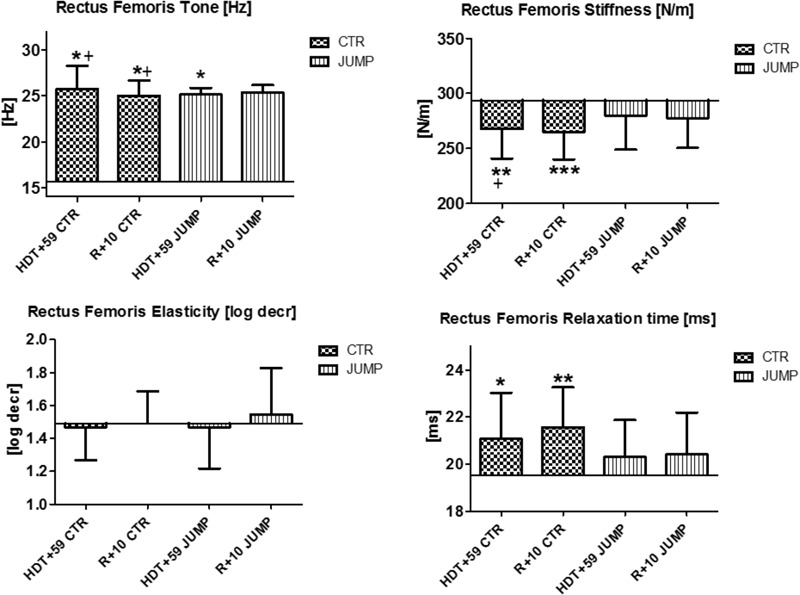
Rectus femoris (MP5/6). Oscillation signal patterns in RSL bed rest study. ABL = Average Baseline (Tone HDT+1 = 15.64; Stiffness HDT+1 = 293.71; Elasticity HDT+1 = 1.49; Relaxation HDT+1 = 19.51). ∗p < 0.05, ∗∗p < 0.01, ∗∗∗p < 0.001 ± SD, +Spearman ρ.